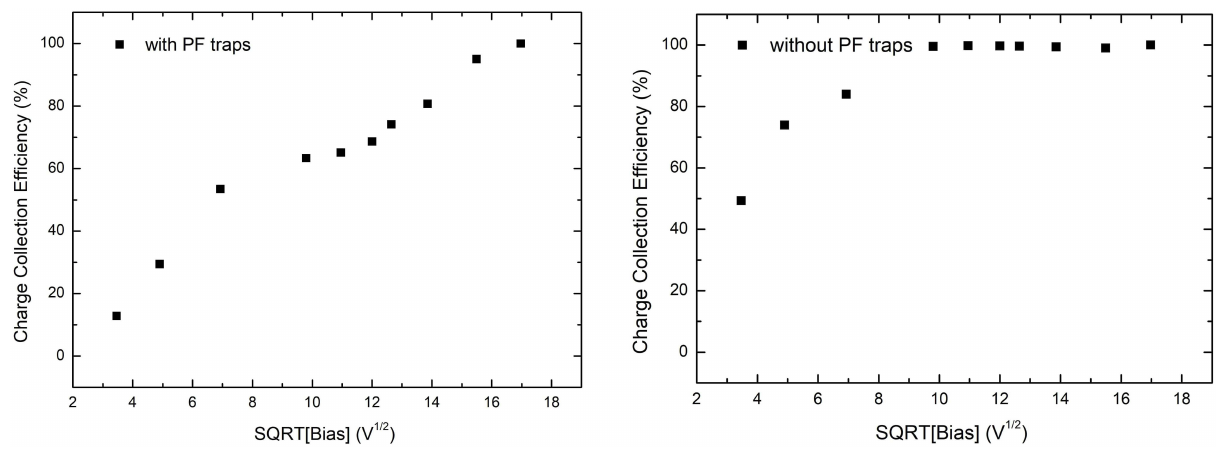
FIGURE 8 | CCE vs. √ V for the 12 µ m thick a-Si:H n-i-p device. Simulations were run with (left) and without (right) the Poole-Frenkel trap model activated.